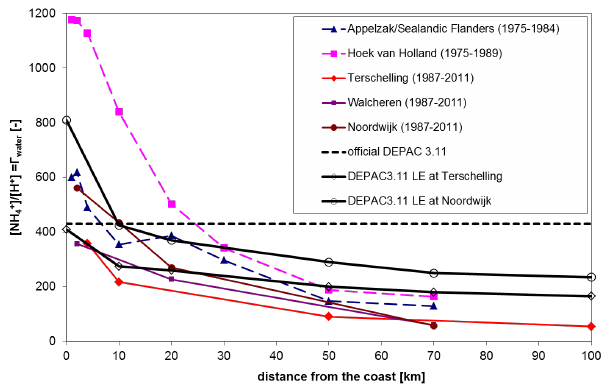
Figure 1. Molar ratio between the NH 4+ and H + concentration in sea water for 7 transects Fig. 1. Molar ratio between the NH + and H + concentration in sea perpendicular to the coast in the Netherlands (data from www.waterbase.nl) 4 water for 7 transects perpendicular to the coast in the Netherlands + and H + concentration, i.e. 0 (data from www.waterbase.nl). Fig. 2. Molar ratios between the NH 4 values, in sea water as used in the LOTOS-EUROS model for the European domain. The grid resolution in this domain is 0.50 ◦ lon- gitude × 0.25 ◦ latitude ( ∼ 28 × 28km 2 )